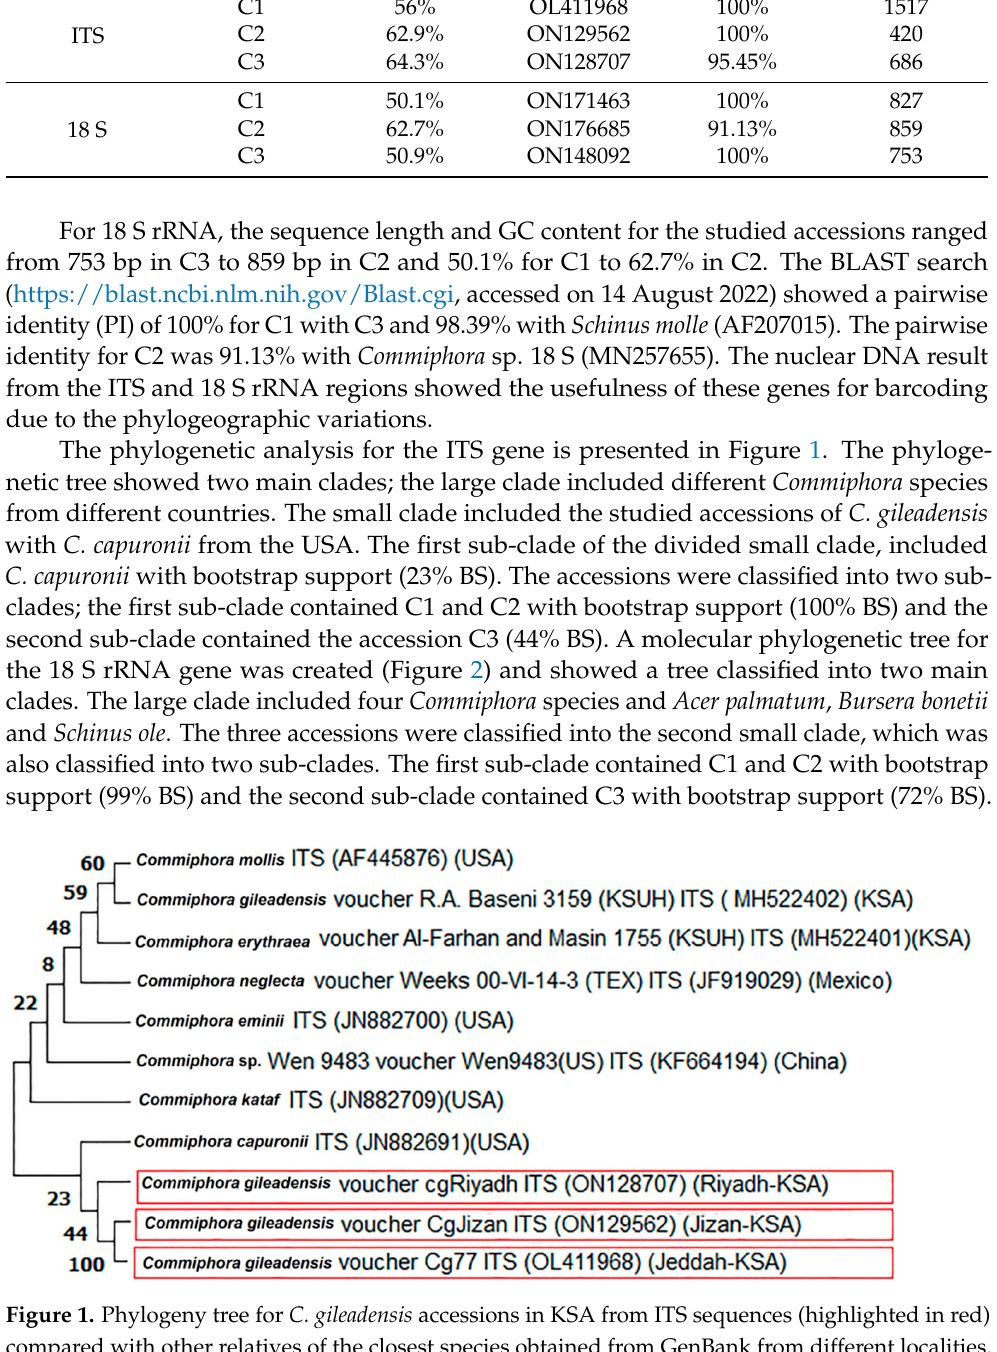
Table 1. Data generated from nuclear DNA region (ITS and 18 S) for the studied C. gileadensis acces- sions.